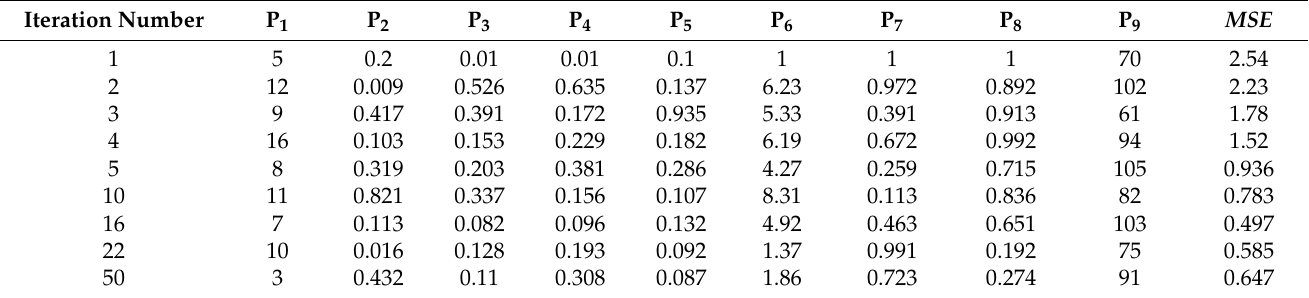
Table 3. Partial results of optimization of